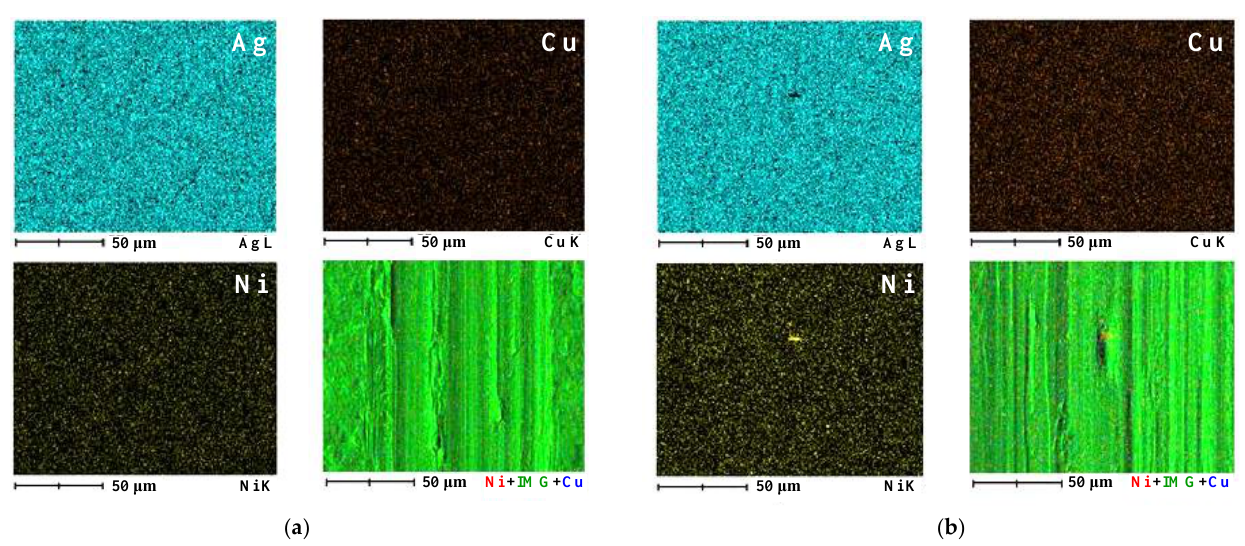
Figure 15. Elemental mapping images by EDS analysis of the worn surfaces of plate specimens obtained in ( a ) Phase I and ( b ) the beginning of Phase II.